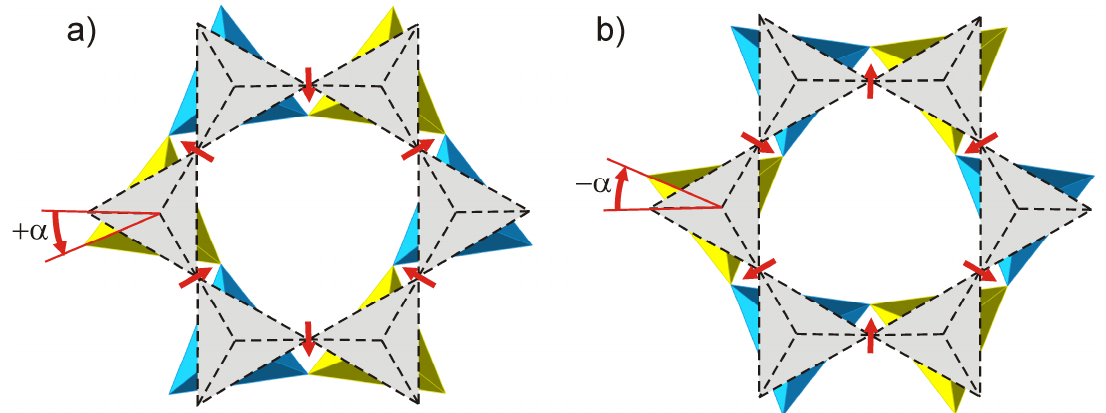
Figure 4. Ditrigonal rotation of tetrahedra in an ideal six-membered tetrahedral ring (gray tetrahedra with dashed outlines) results in two different versions of distorted ring with positive ( a ) and negative ( b ) values of the α angle. Red arrows indicate directions of shifts of bridging O atoms from their ideal positions.